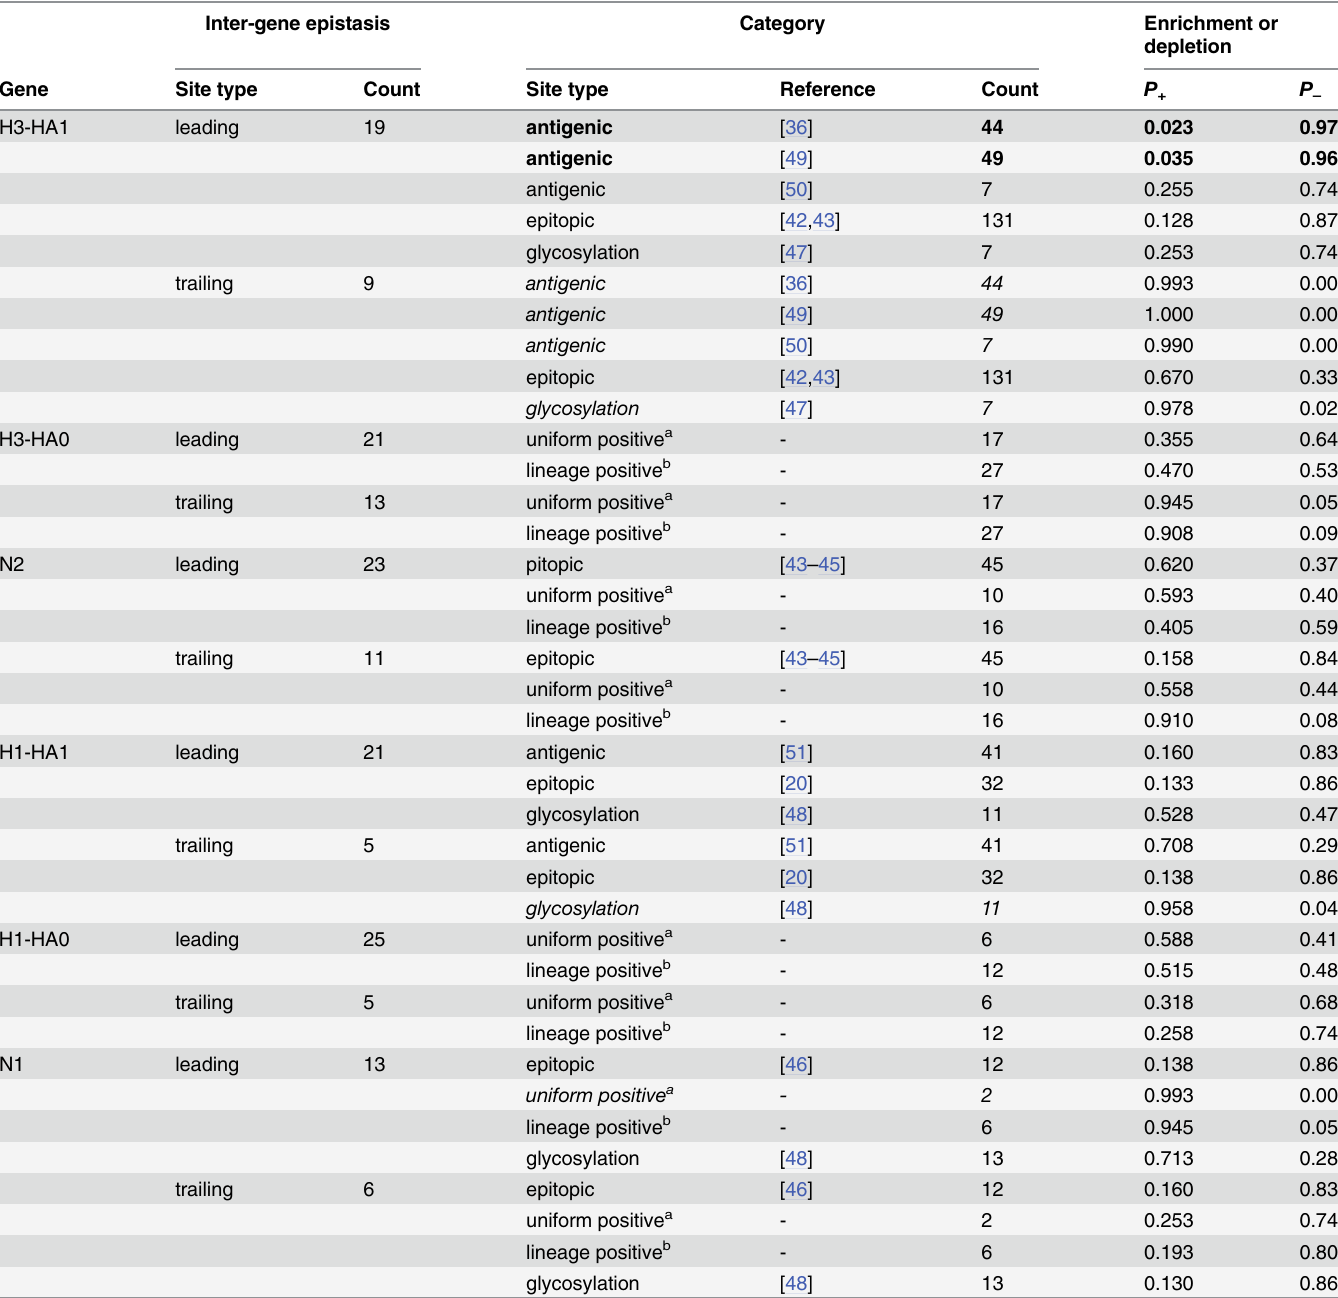
Table 3. Comparisons of sets of sites evolving under inter-gene epistasis with sets of sites with known